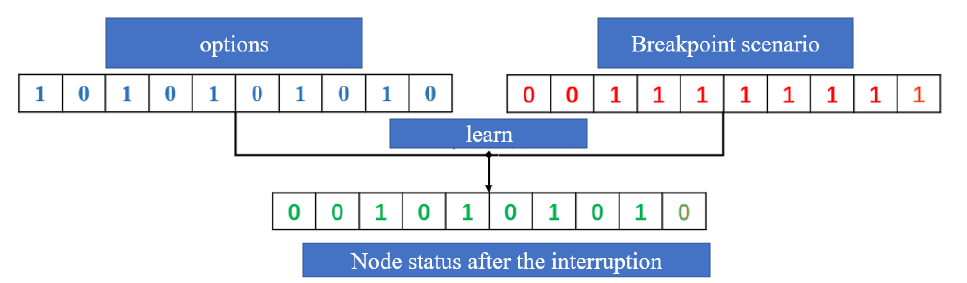
Figure 6. The swarm reconstruction scheduling allocation algorithm.